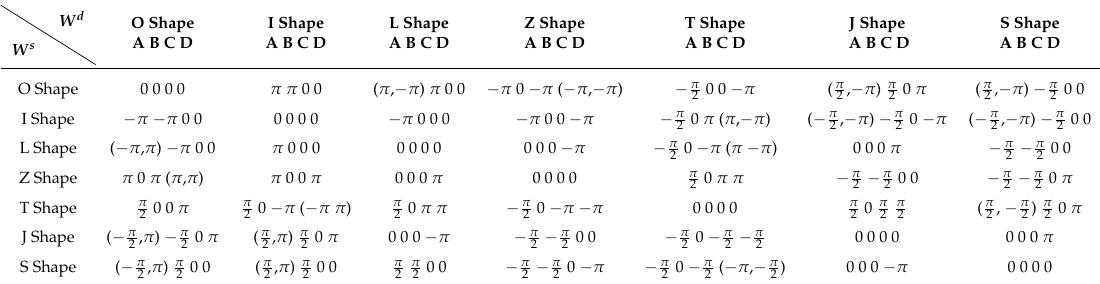
Table 3. Tuning radius of each block when hTtro transforms its shape from Source waypoint W s to next Destination waypoint W d .